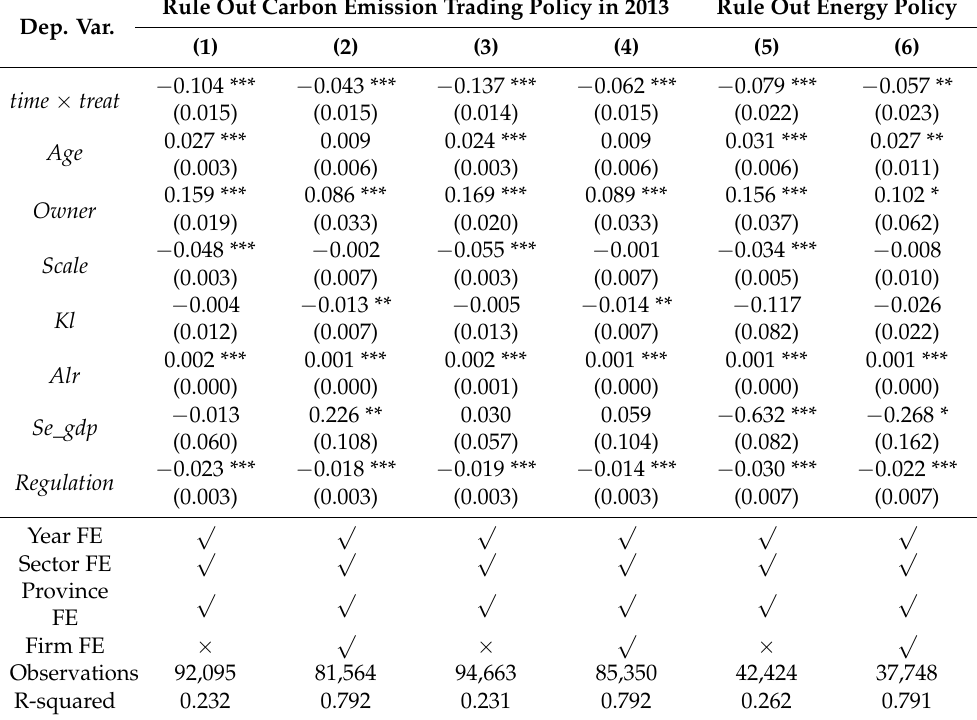
Table 9. Excluding Other Policy Distractions. Dep.